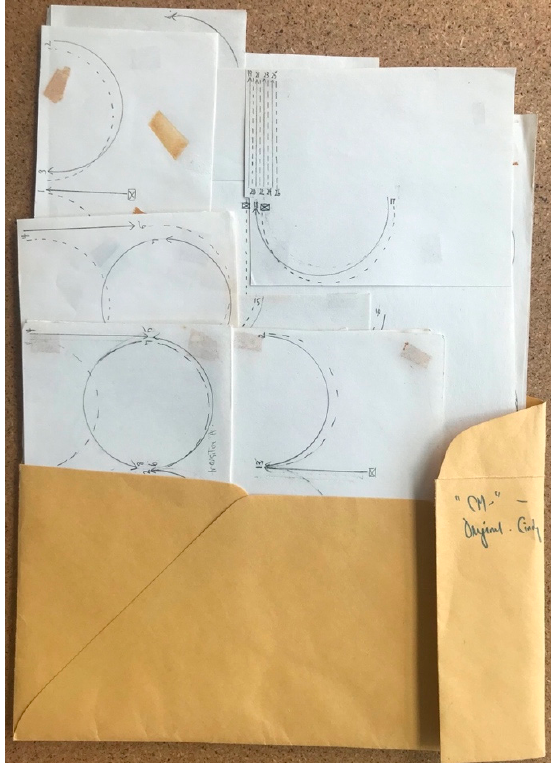
Figure 8. Lucinda Childs, cut-outs for Calico Mingling (1973), graphite on paper, 12.7” × 9” × 0.1”, Fonds Lucinda Childs—Médiathèque du Centre national de la danse.